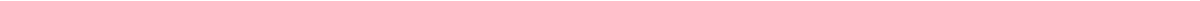
Fig. 2 Tctex-1 regulates Dsg1 localization at the cell – cell interface. a NHEKs treated with control or Tctex-1 siRNA were analyzed for endogenous Dsg1 localization (differentiated condition), or Dsg2 and E-cadherin localization (undifferentiated condition). b Line scan analysis of border intensities for Dsg1, Dsg2, and E-cadherin in NHEKs with or without Tctex-1 knockdown (three independent experiments, at least 50 borders were analyzed per condition in representative experiment, *** p < 0.001, unpaired two-tailed t test). c , d Dsg1-FL-Flag or Dsg1-909-Flag-infected undifferentiated NHEKs were stained for Flag. Line scan analysis of border intensities for ectopic Dsg1 proteins is shown on the graph (four independent experiments, at least 50 borders were analyzed per condition in representative experiment, *** p < 0.001, unpaired two-tailed t test). e Subcellular fractionation of undifferentiated NHEKs expressing Dsg1-FL-Flag or Dsg1-909-Flag. Collected fractions were analyzed for plakoglobin (PG) (a cytoplasmic constituent of the desmosome), E-cadherin and Flag. C = cytoplasm, S = soluble membrane-bound fractions (M, membrane + N, nuclear), I = insoluble membrane bound fractions (P, pellet + Pusb, urea sample buffer solubilized pellet). f Quanti fi cation of the percentage of Dsg1-FL-Flag or Dsg1-909-Flag in soluble and insoluble membrane fractions ( fi ve independent experiments; ** p < 0.01, unpaired two-tailed t test). g Structured illumination microscopy images of ectopic Dsg1-FL- Flag or -909-Flag mutant (green) and CT-B-labeled lipid rafts (red). E-cadherin staining in the top panels indicates the cell – cell border location. Rectangles mark zoomed in areas. h Pearson ’ s correlation coef fi cients for Dsg1-FL-Flag/CT-B-labeled lipid rafts or Dsg1-909-Flag/CT-B-labeled lipid rafts (from one representative experiment out of 3, * p < 0.05, unpaired two-tailed t test). i Western blot of GFP immunoprecipitation from undifferentiated NHEKs expressing GFP or Dsg1-GFP + / − ectopic Tctex constructs probed for Dsg1, Tctex-1, GFP, and PG (positive control for Dsg1 interactions). j Subcellular fractionation of undifferentiated NHEKs co-expressing Dsg1-FL-Flag with Tctex-wt-Flag (Twt) or Tctex-t94e-Flag (Tt94e). Collected fractions were analyzed for PG, Dsg1, and Tctex-1. k Quanti fi cation of the percentage of Dsg1-FL-Flag in soluble and insoluble fractions in the presence of Tctex-wt or Tctex-t94e (three independent experiments; ** p < 0.01, unpaired two-tailed t test). Scale bars = 10 μ m. Error bars represent